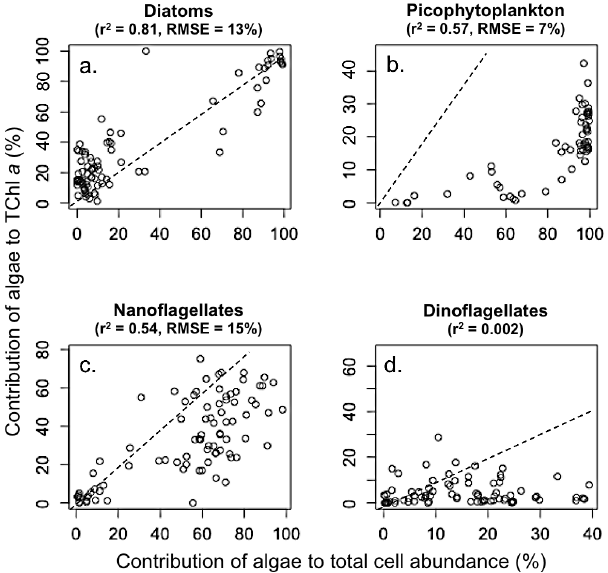
Figure 8. Scatter diagrams of the contribution of (a) diatoms, (b) pi- cophytoplankton, (c) nanoflagellates and (d) dinoflagellates to total chlorophyll a (Chl a ) concentration (calculated by CHEMTAX) as a function of their contribution to total cell abundance. The dashed line represents a 1 : 1 relationship. The Pearson correlation coeffi- cient ( r 2 ) is indicated for each algal group. The root-mean-square error (RMSE) depicts the predictive capabilities of cell abundance from the CHEMTAX-derived algal groups. In total, 95% of the al- gal cell abundance estimated from the CHEMTAX-derived algal groups is in the range ± 2 × RMSE from the least-squares regres- sion